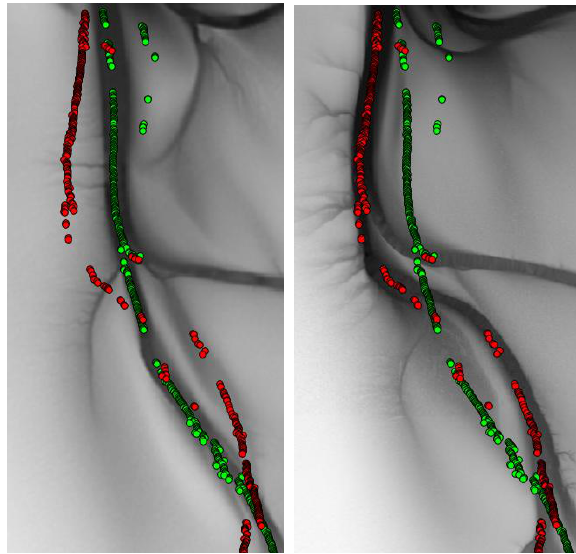
Figure 8. Magnitude of the shifting of the channel in Area a for 2012 in relation to